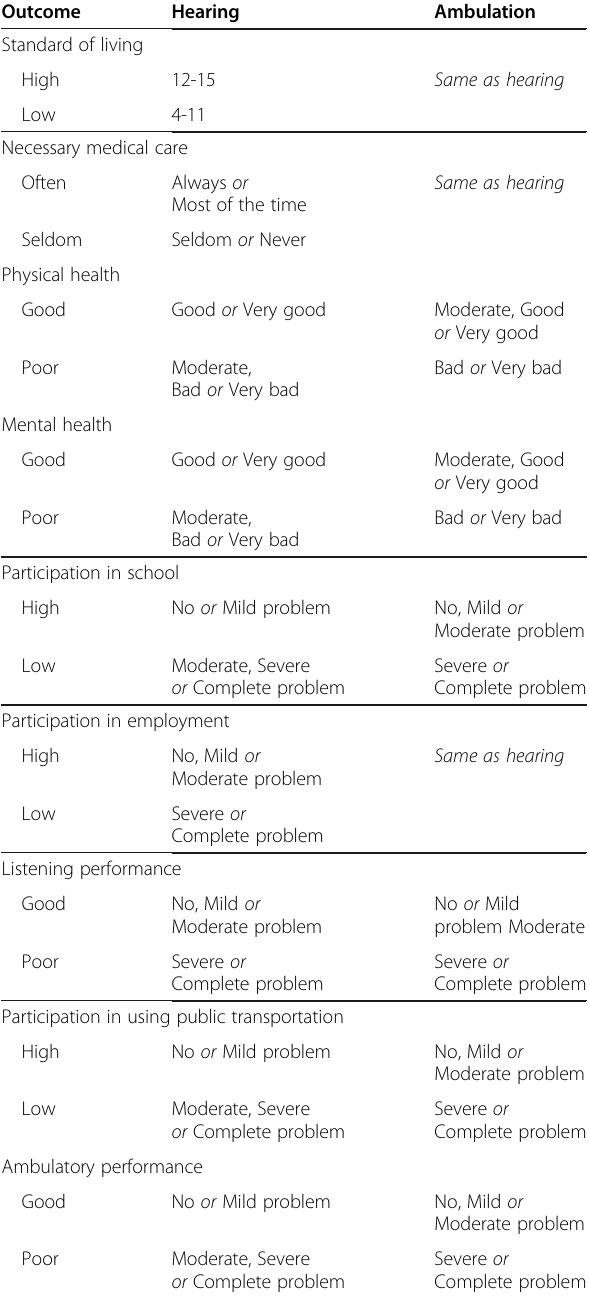
Table 2 Dichotomization points of continuous outcome variables for hearing and ambulation